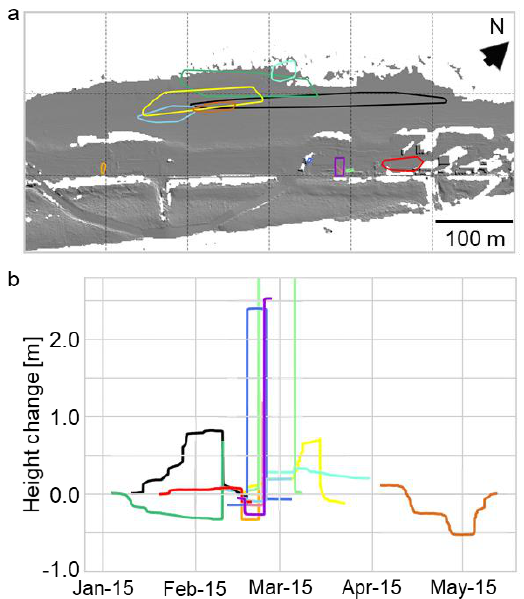
Figure 3. (a) Spatial extent in the scene and (b) change history for twelve 4D objects-by-change that are used for analysis of spatiotemporal segmentation with reduced resolutions.